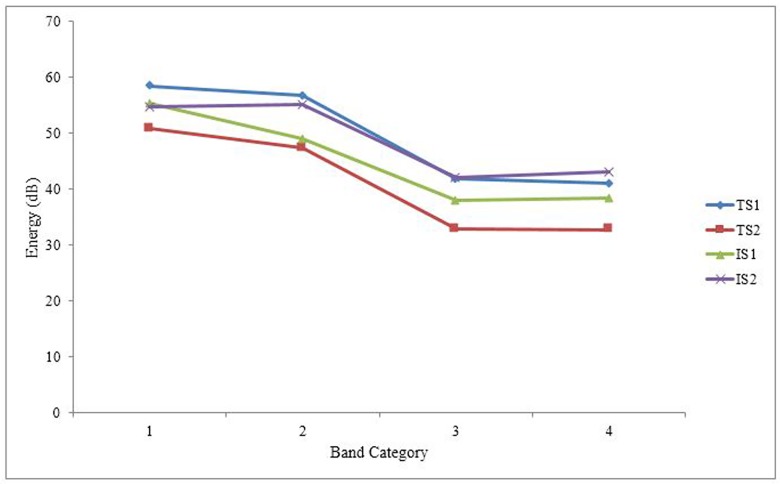
Spectral energy of the four stress conditions across the four bands.